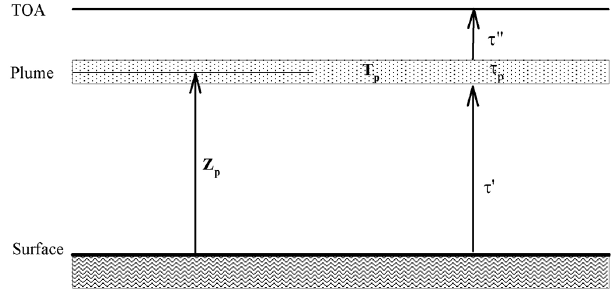
Fig. 2. Schematic representation of the atmospheric model